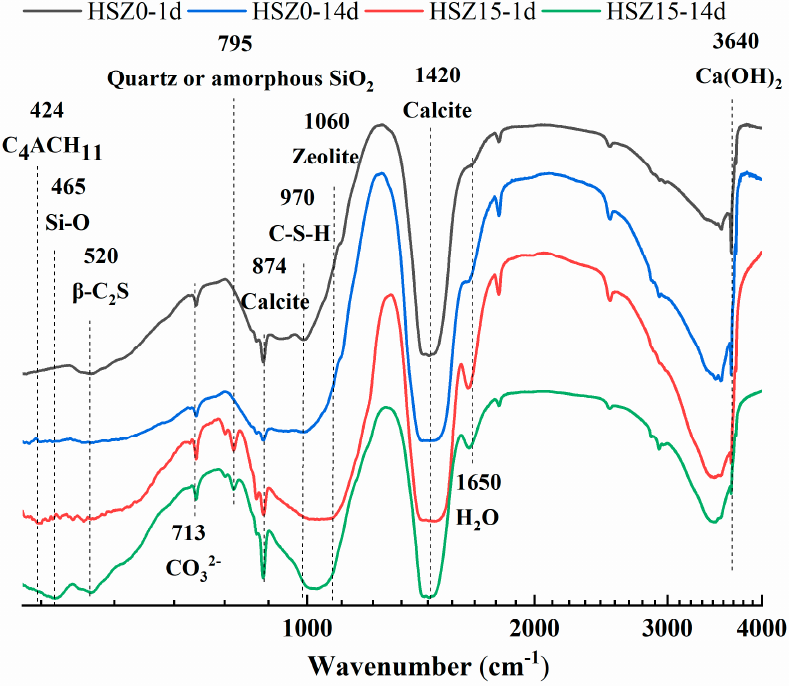
Figure 9. Fourier transform infrared spectroscopy (FT-IR) spectra of HSZ0 and HSZ15 after 1 day and 14 days of hydration.